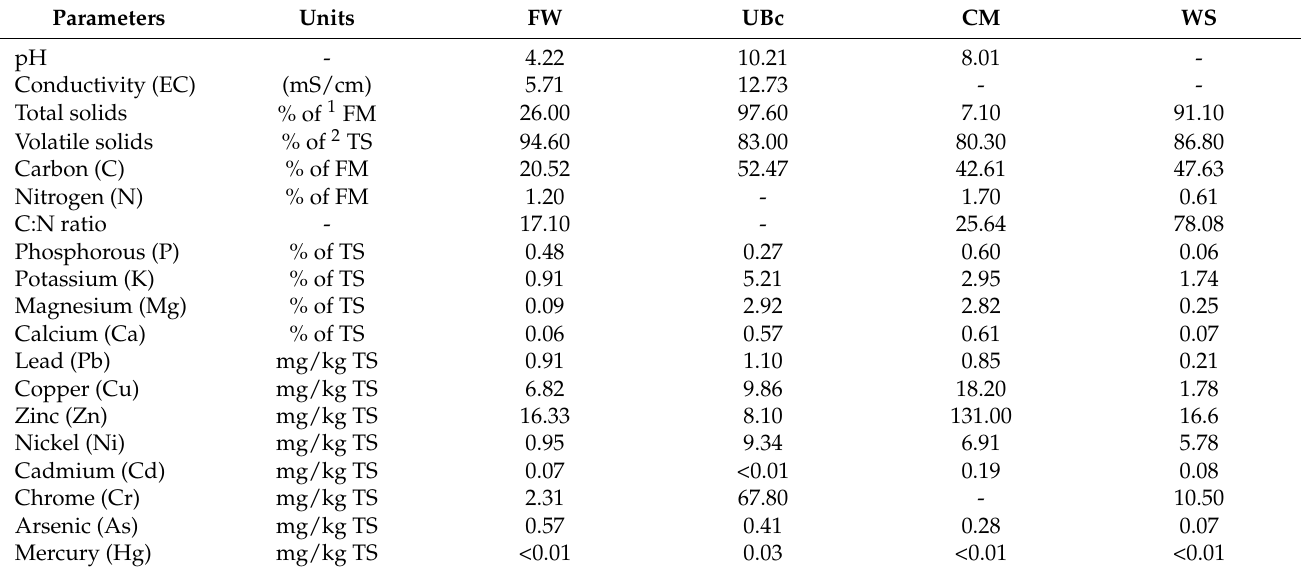
Table 3. Physio-chemical characteristics of the raw